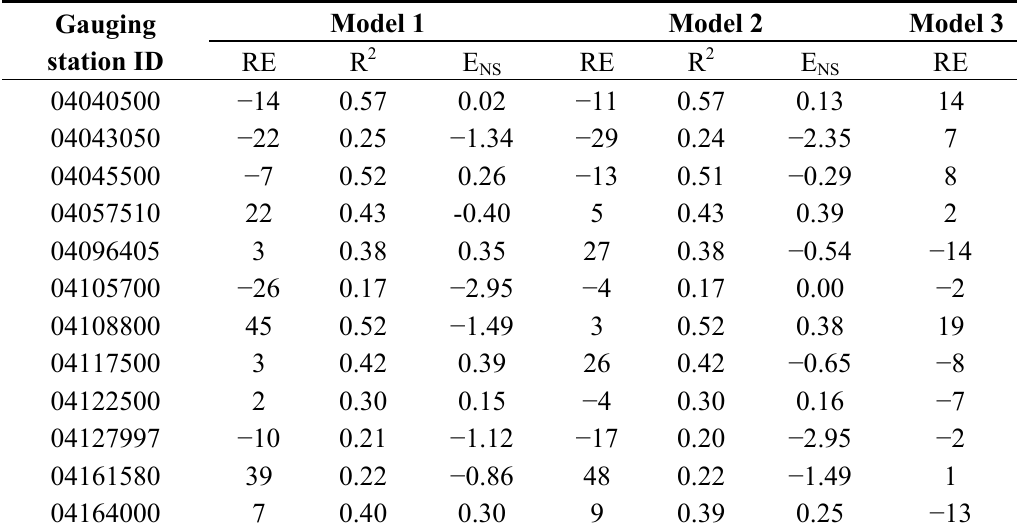
in watersheds used for model NS